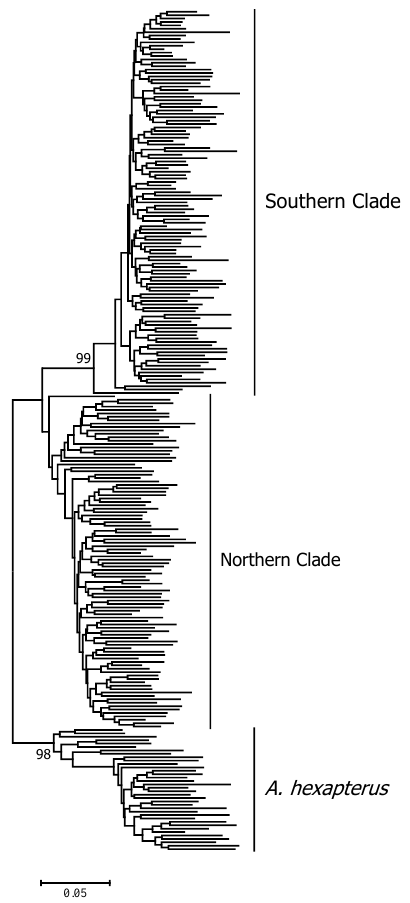
Figure 3. NJ tree based on Nei and Li’s (1979) genetic distances among all Ammodytes individuals [22]. Bootstrap supports of >90% in 1000 replicates are shown.